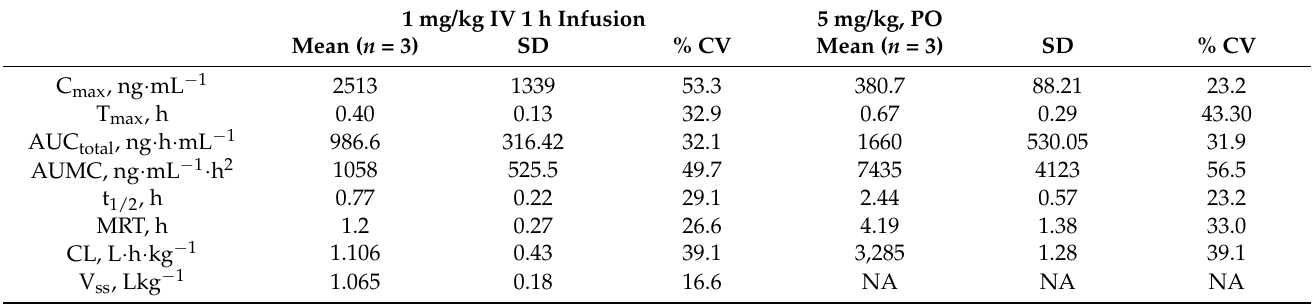
Table 1. PK of GLP-26 administered by IV infusion (1 mg/kg over 0.5 h) or PO (5 mg/kg) to male cynomolgus monkeys. N = number of monkeys; C max and T max are maximal observed plasma concentration and the time it was observed, respectively; AUC total = area under the plasma concentration versus time curve (extrapolated); CL/F = dose/AUC total , where F is the fraction of the dose systemically absorbed (=1 for IV administration); t1/2 = terminal first-order half-life; AUMC = area under the first moment curve; MRT = mean residence time; Vss = steady-state volume of distribution; SD = standard deviation; %CV = percent coefficient of variations. NA = not applicable. The percent of GLP-26 bound in the plasma of cynomolgus monkeys was